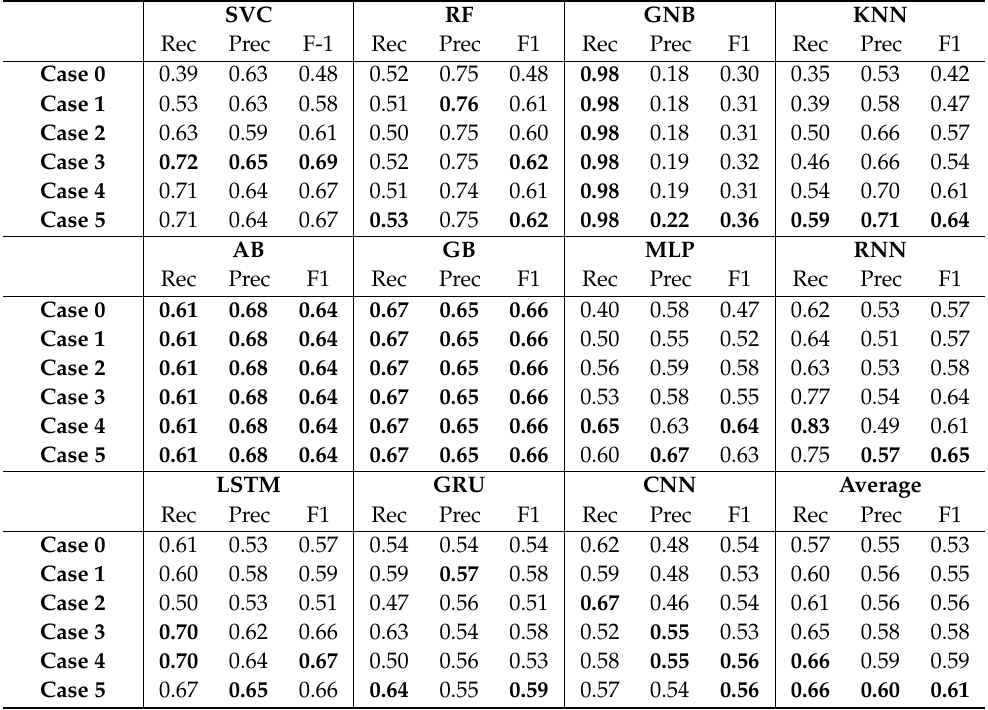
Table A4. Test results for induced/evolved rules used as an additional predictive feature, considering a time prediction horizon of +3